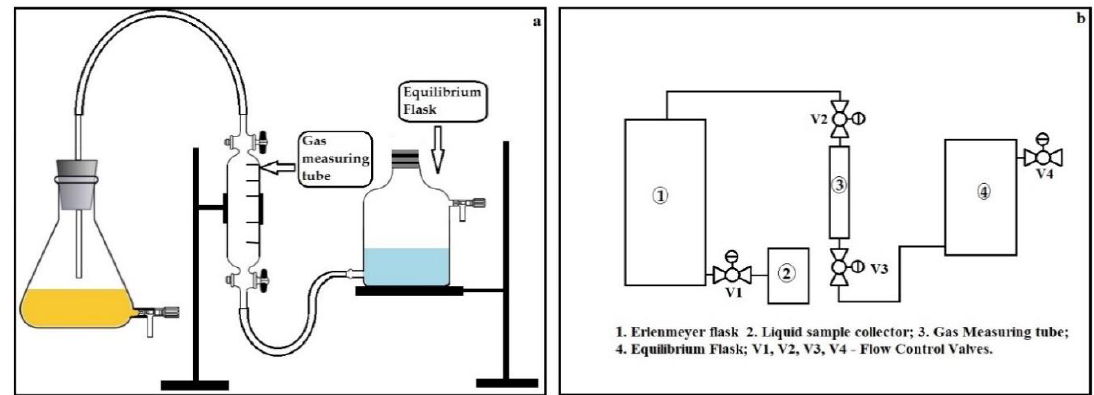
Figure 2. Experimental setup for batch test ( a ); schematic diagram of the experimental setup ( b